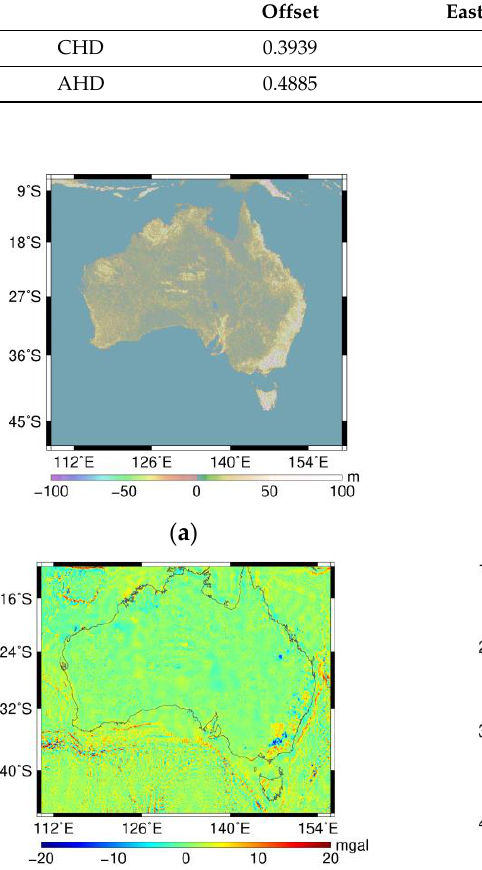
Table 7. The parameter results of the parametric model were calculated using vertical offsets of the Chinese height datum (CHD) and the Australian height datum (AHD) (unit: m).